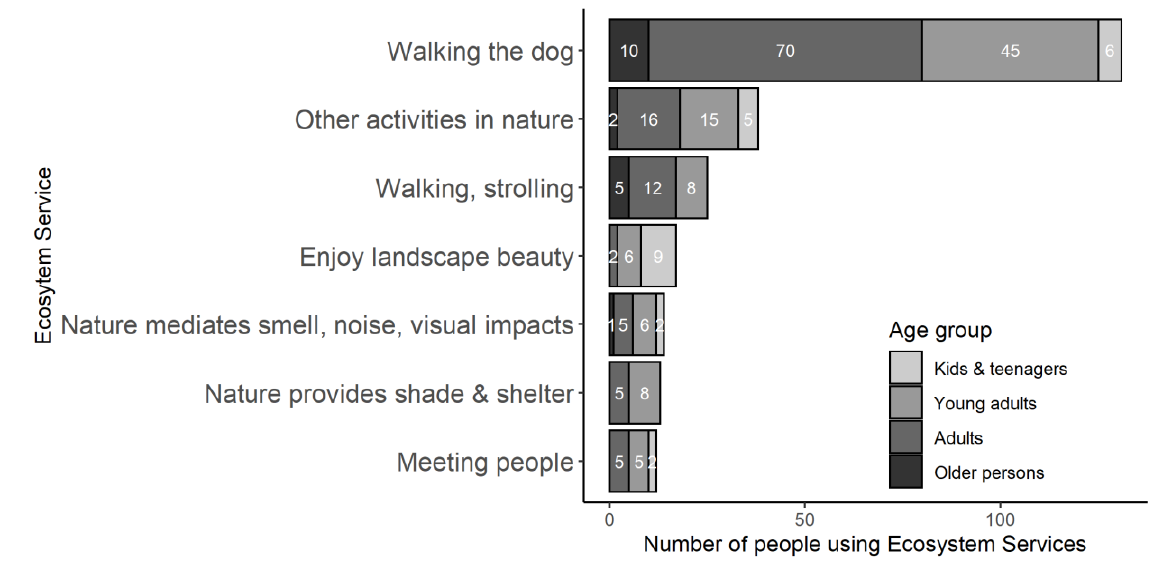
Figure A1.8: Respondents of different age groups from surveys (n=250) on brownfields and their ecosystem used service (question with predefined ecosystem services). Ecosystem services that were used from less than 10 respondents were aggregated in “Other activities in nature” for graphical reasons.